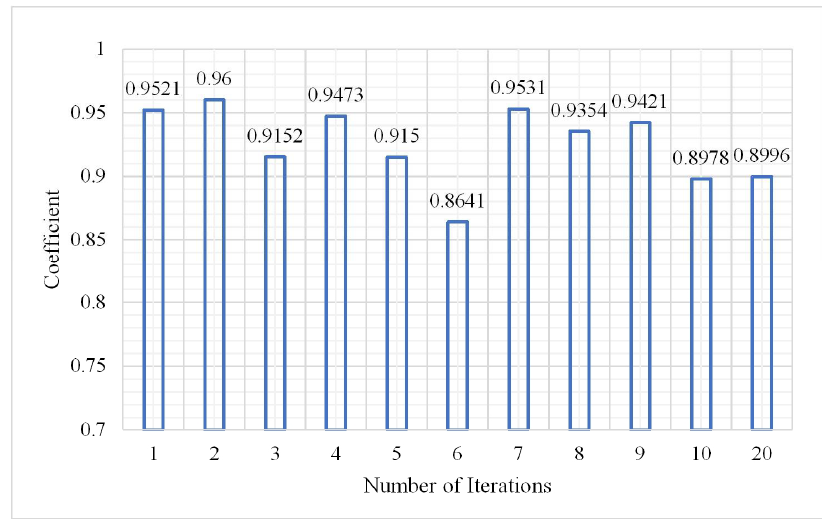
Figure 16. Change in overall accuracy.